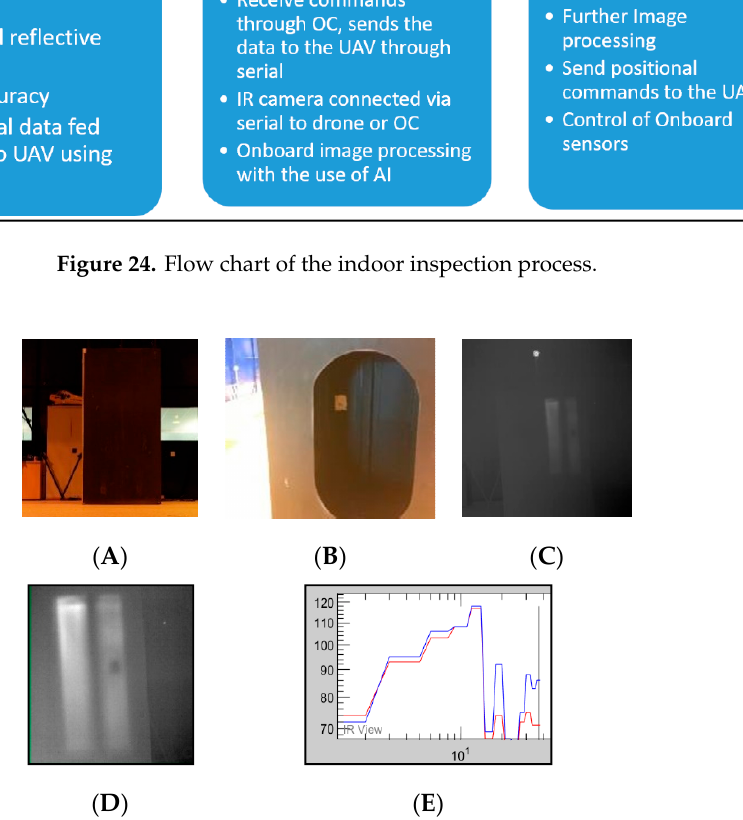
Figure 25. ( A ) Red/green/blue (RGB) image of the composite wing. ( B ) Rear image of the wing displaying the debris inside. ( C )IR image taken of the composite wing using the Zenmuse XT camera. ( D ) Debris prompted a contrast difference in the thermal data. ( E ) Temperature/time graph. The images where taken at different locations. Interference and instability resulted in corrupted data.